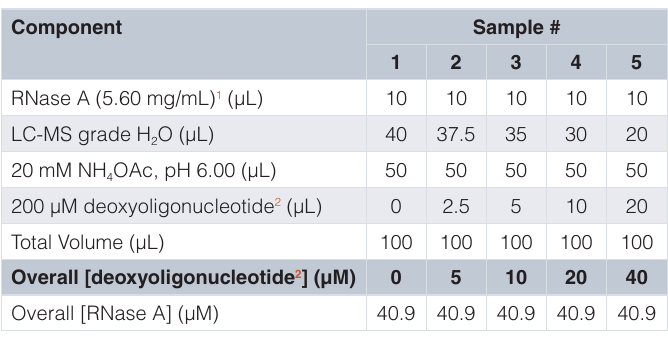
adducts (X) 1 . The +8 i